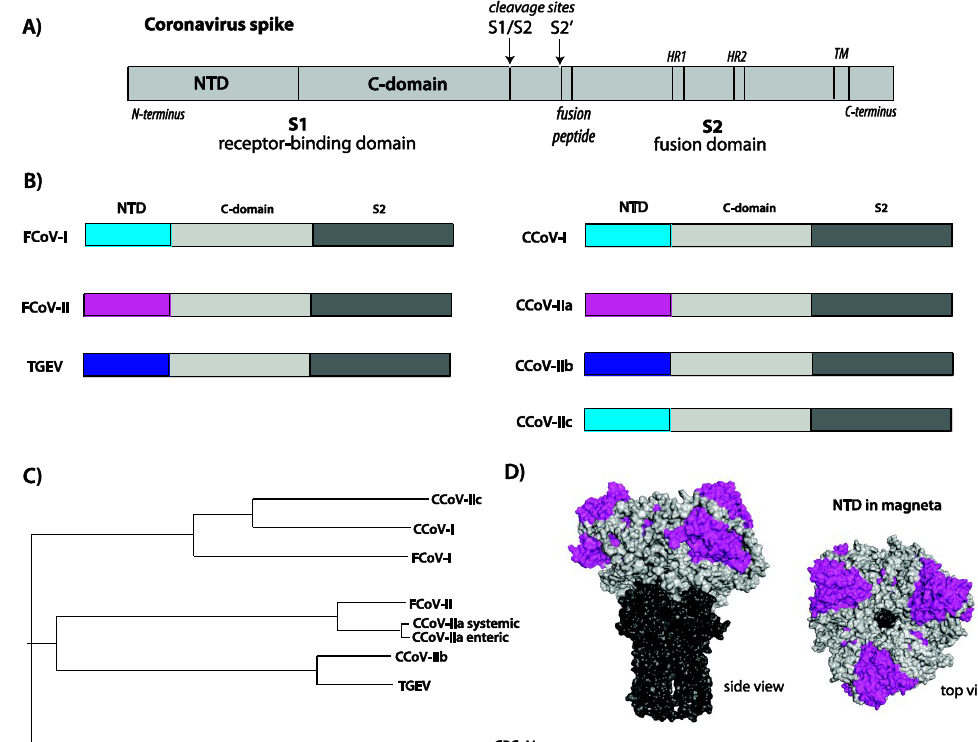
FigTree software [46]; ( D) Structural model of a coronavirus spike protein based on PDB file 1T7G [47], in surface rendering. The NTD is colored magenta, the remainder of S1 is light gray and the S2 domain is colored dark gray. Two views of the trimeric spike are shown, a side view and a top